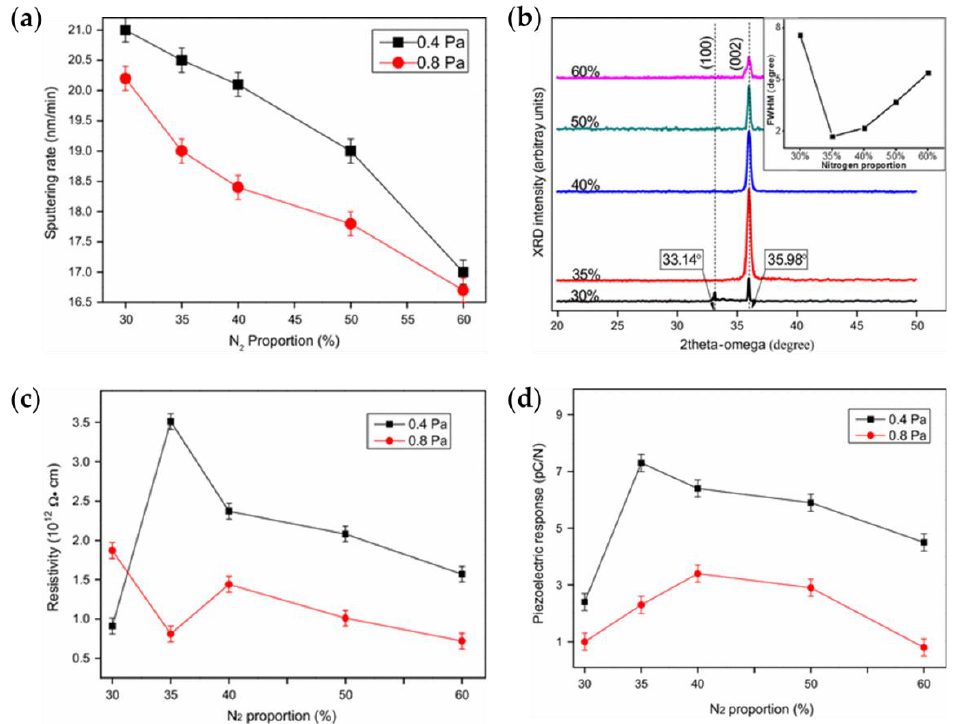
Figure 4. Effect of sputtering atmosphere on ( a ) sputtering rate, ( b ) crystal quality, ( c ) resistivity, and ( d ) piezoelectric response. Reproduced with permission from Ref. [6]. ( d ) piezoelectric response. Reproduced with permission from Ref.